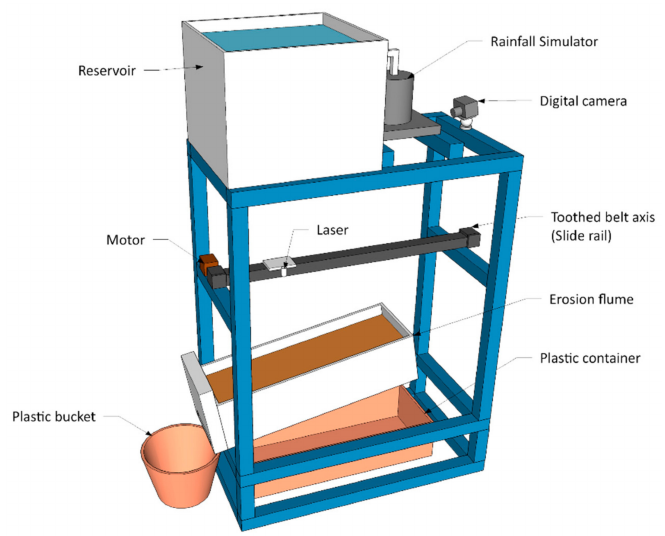
Figure 2. Setup of the sloping flume erosion